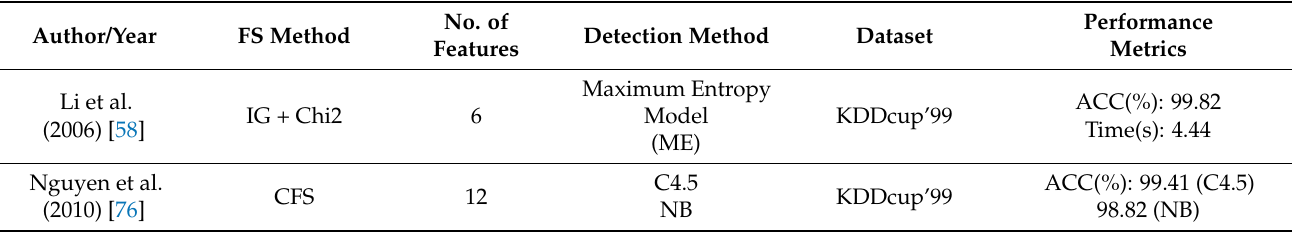
Table 8. Comparison of filter-based feature selection